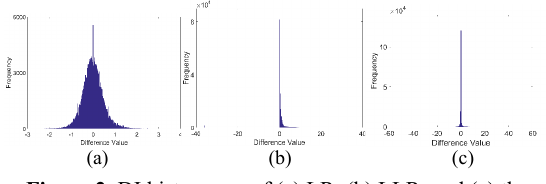
Figure 2. DI histograms of (a) LR, (b) LLR, and (c) the proposed method.